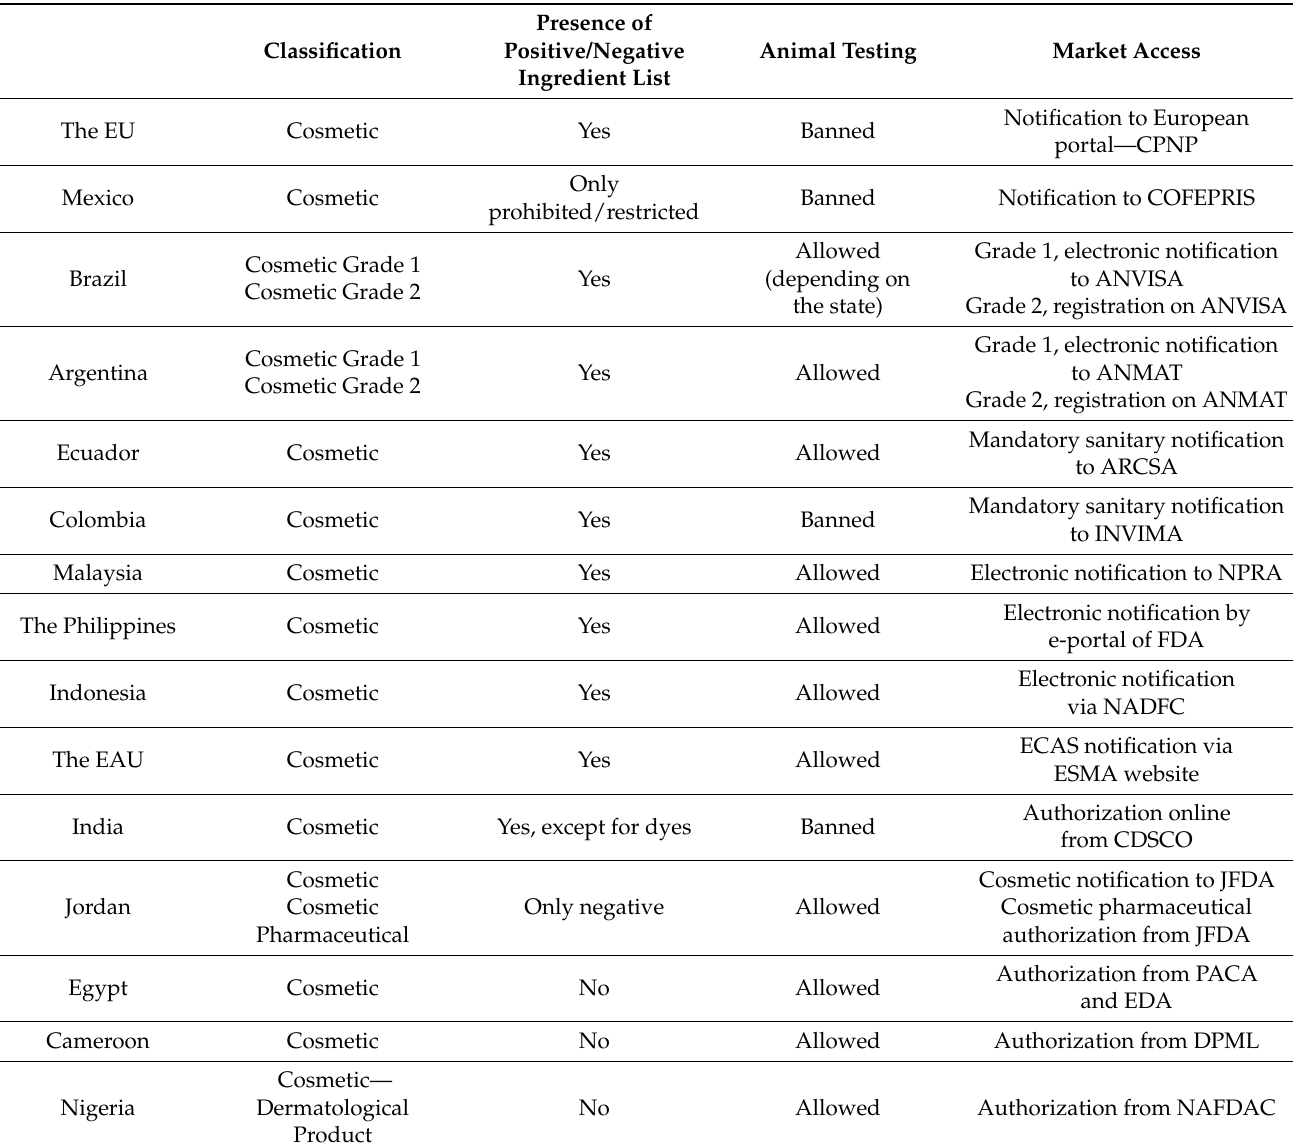
Table 3. Regulatory aspects: ingredients list, animal testing, and approval